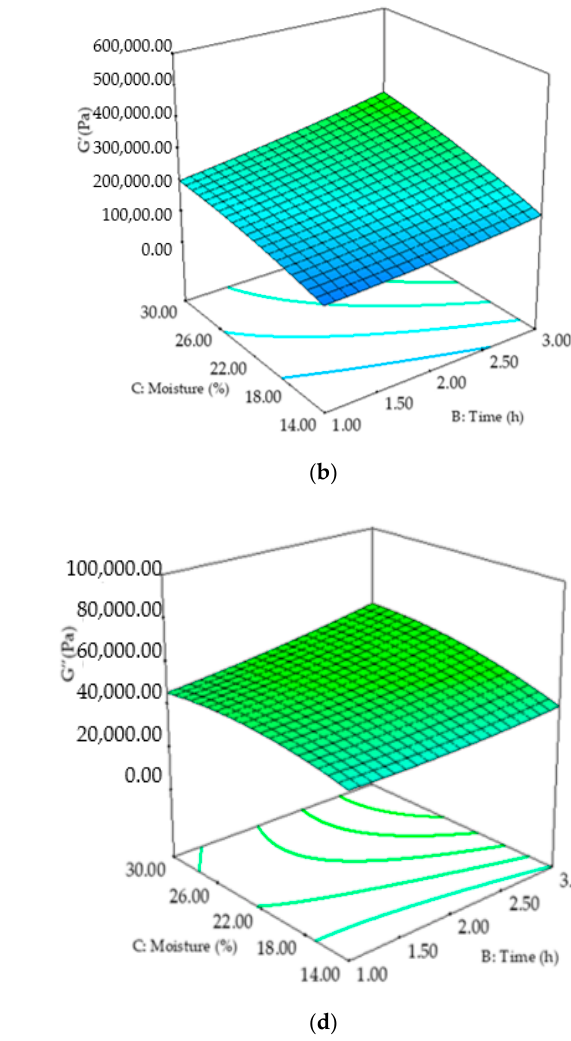
Figure 2. Three-dimensional response surface plots presenting the synergistic effects of factors on dough elastic G’ ( a , b ) and viscous G” ( c , d ) moduli.